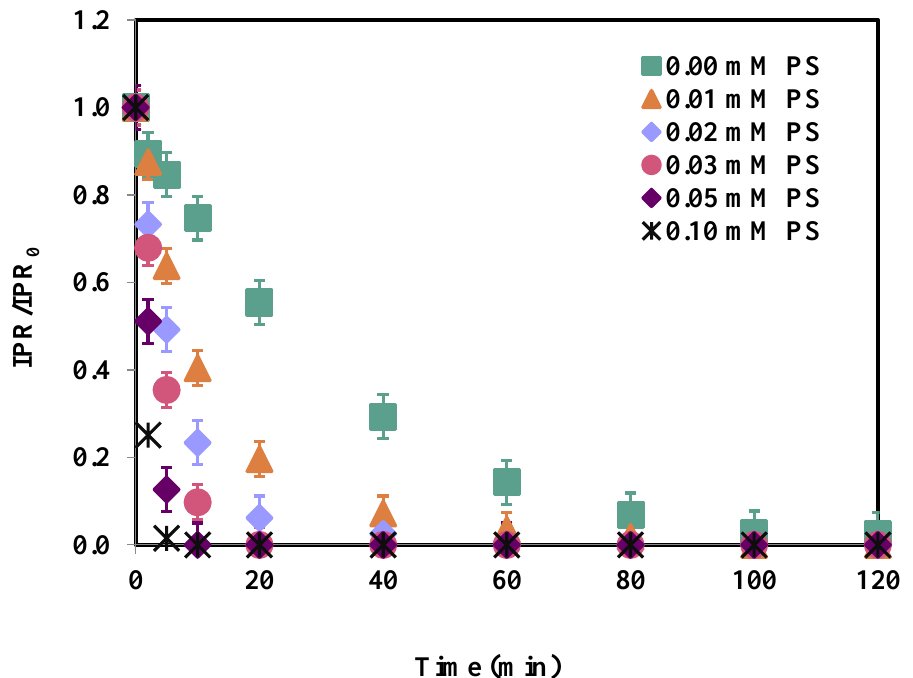
Figure 1. Changes in normalized IPR concentrations during UV-C and UV-C/PS treatments in DW at varying initial PS concentrations. IPR = 2 mg/L; UV-C intensity = 0.5 W/L; pH = 6.2.